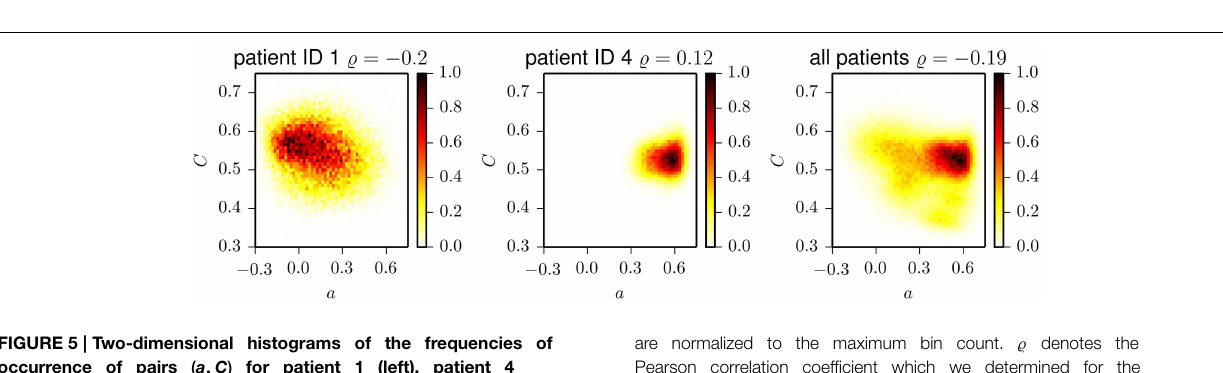
FIGURE 4 | Same as Figure 1 but for the clustering coefficient C .